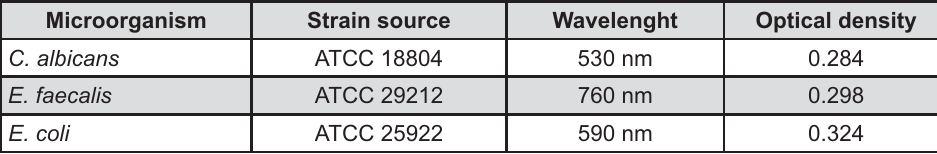
Figure 1- Strains source, wavelength and optical density adopted for obtaining of standardized suspensions (10 6 cells/mL)